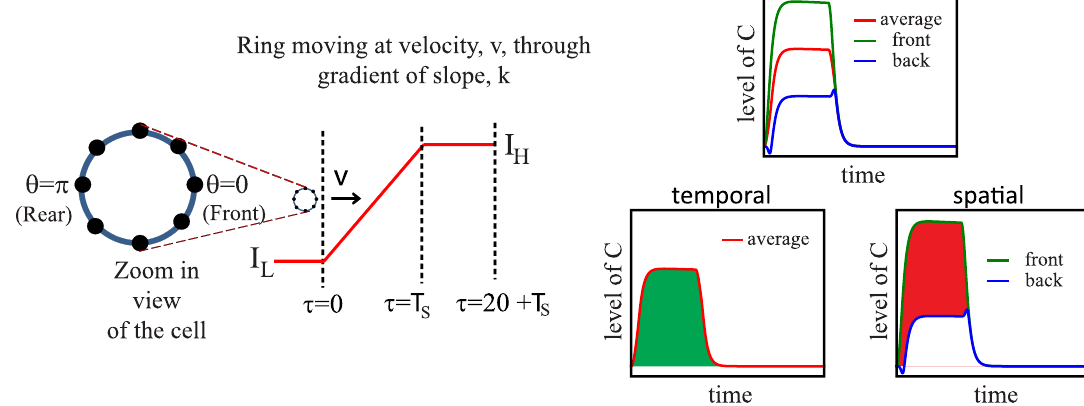
Fig 2. Steps in the computational modelling of network motifs. other. In temporal sensing, the cell compares the level of C with the steady state level of C (area highlighted in green) (Fig 2, step 4, temporal) whereas in spatial sensing, the cell com- pares the level of C at the front half and back half of the cell (area highlighted in red) (Fig 2, step 4, spatial). We identify five dimensionless terms, namely the diffusivities of the activator (protein A ), repressor (protein B ) and output (protein C ) proteins, all normalised to the by the moving cell, and the ratio of cell speed to the product of diameter and signaling rate